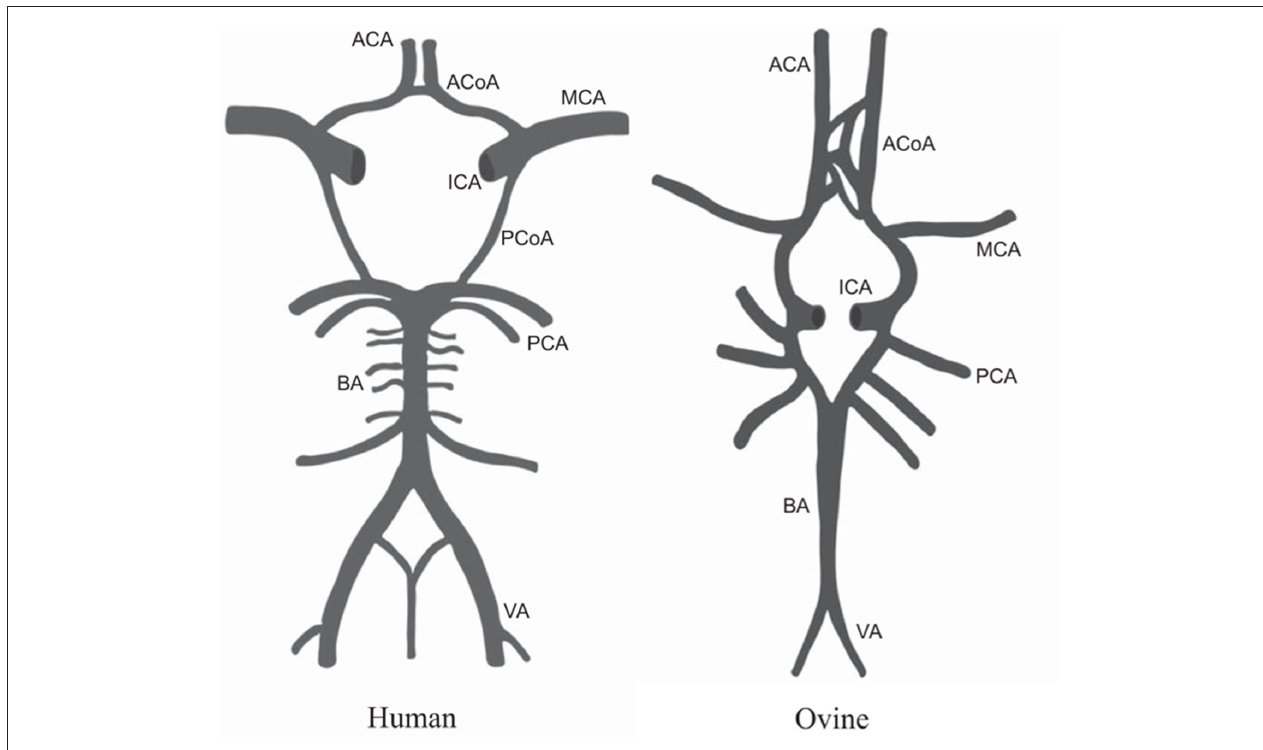
FIGURE 3 | Comparison of the anatomy of the circle of Willis in humans and sheep. MCA, middle cerebral artery; ICA, internal carotid artery; ACoA, anterior communicating artery; ACA, anterior cerebral artery; PCoA, posterior communicating artery; PCA, posterior cerebral artery; BA, basilar artery; VA, vertebral artery. Figure adapted from Large animal models of stroke and traumatic brain injury as translational tools by Sorby-Adams et al. ( 15) with permission from The American Physiological Society.